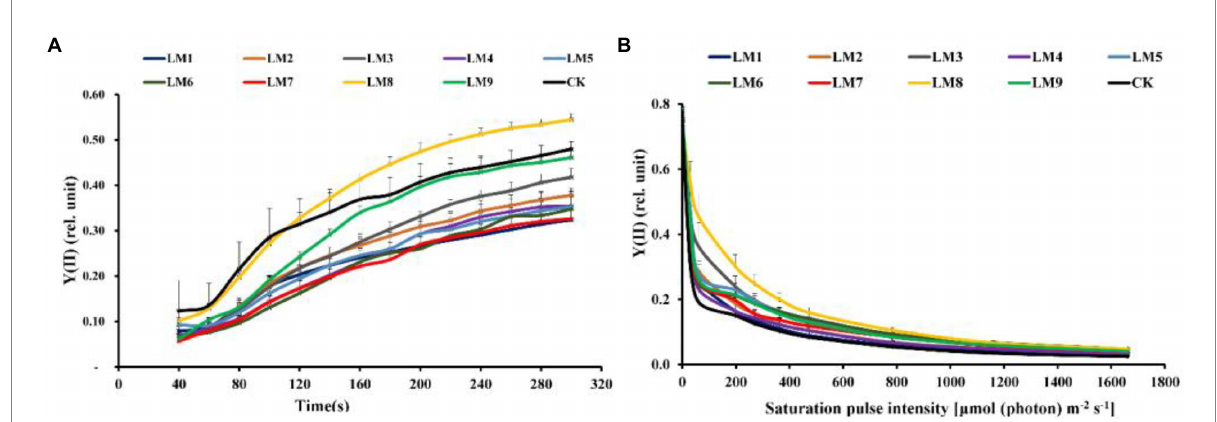
FIGURE 6 Effects of LED light modes on the induction kinetics of chlorophyll a fluorescence in dark-acclimated (A) and light-acclimated (B) of effective quantum yield of PSII photochemistry Y(II) in strawberry leaves. The points represent the means ± SE of 16 (4 × 4) repeats, followed by the identical letters, indicating that the Duncan test found no significant differences ( p ≤ 0.05).